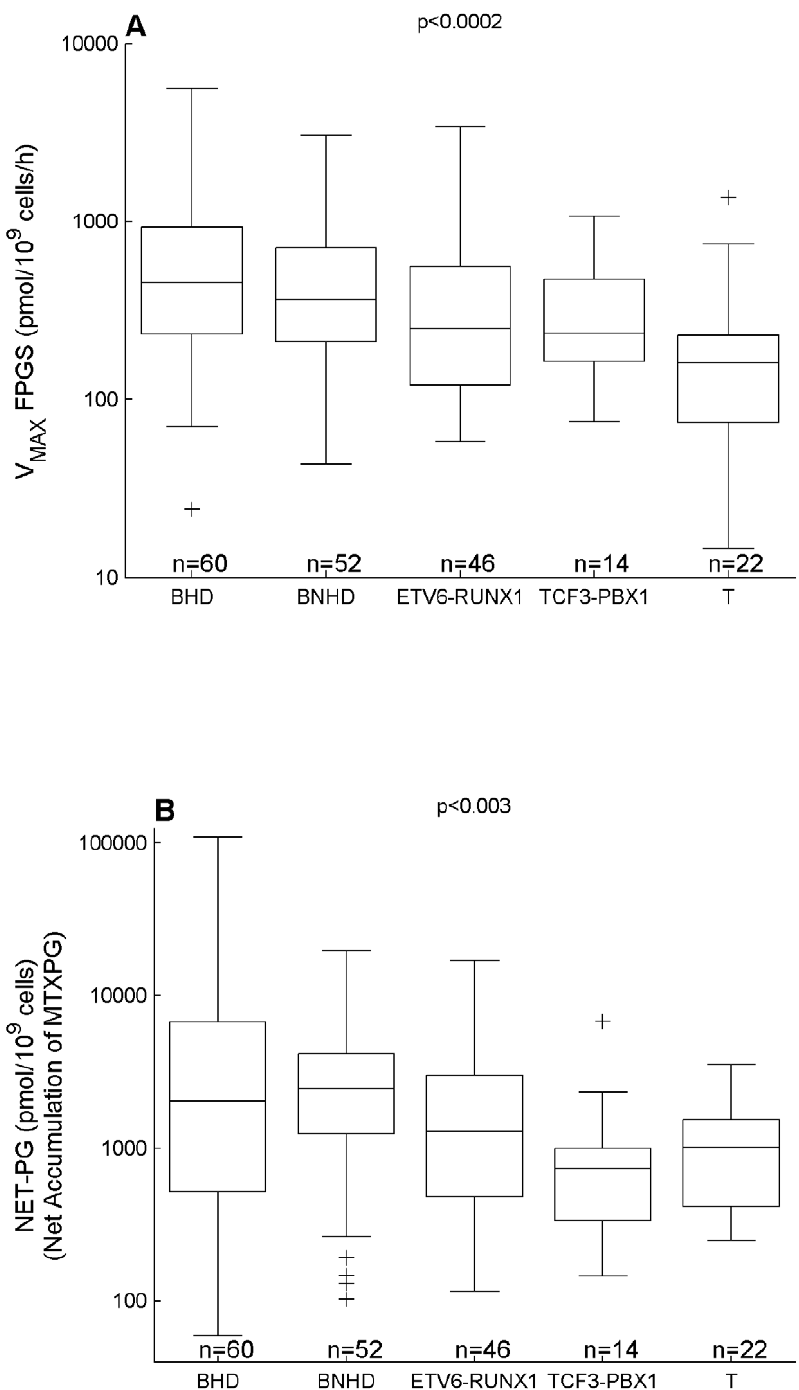
Figure 3. MTX metabolizing enzyme model parameters vs ALL subtype. ( A ) V MAX FPGS vs molecular subtype. ( B ) NET-PG (net accumulation of MTXPG) vs molecular subtype. Median, quartiles, non-outliers range (defined as 1.5 times the interquartile range), and outliers (plus-marks) are depicted. The subtypes are defined as follows: BHD, B-lineage hyperdiploid ALL; BNHD, B-lineage non-hyperdiploid without the t(12;21) [ ETV6-RUNX1 ] or t(1;19) [ TCF3-PBX1 ] translocation; ETV6-RUNX1, B-lineage non-hyperdiploid with the t(12;21) [ ETV6-RUNX1 ] translocation; TCF3-PBX1, B-lineage non- hyperdiploid with the t(1;19) [ TCF3-PBX1 ] translocation; and T, T-lineage ALL. doi:10.1371/journal.pcbi.1001019.g003 decrease in 5mTHF, and only small changes in the remaining and MTXPG intracellular PK parameters defined in this study. folate components relative to the untreated steady-state levels. Figure 6 depicts an individual simulation of the dynamics of the Because MTXPG accumulation was significantly lower in T- various folate components after infusion of 1 g/m 2 of MTX over lineage ALL compared to B-lineage hyperdiploid ALL, we 24 hours. This predicted a two-fold increase in DHF, a one-fold